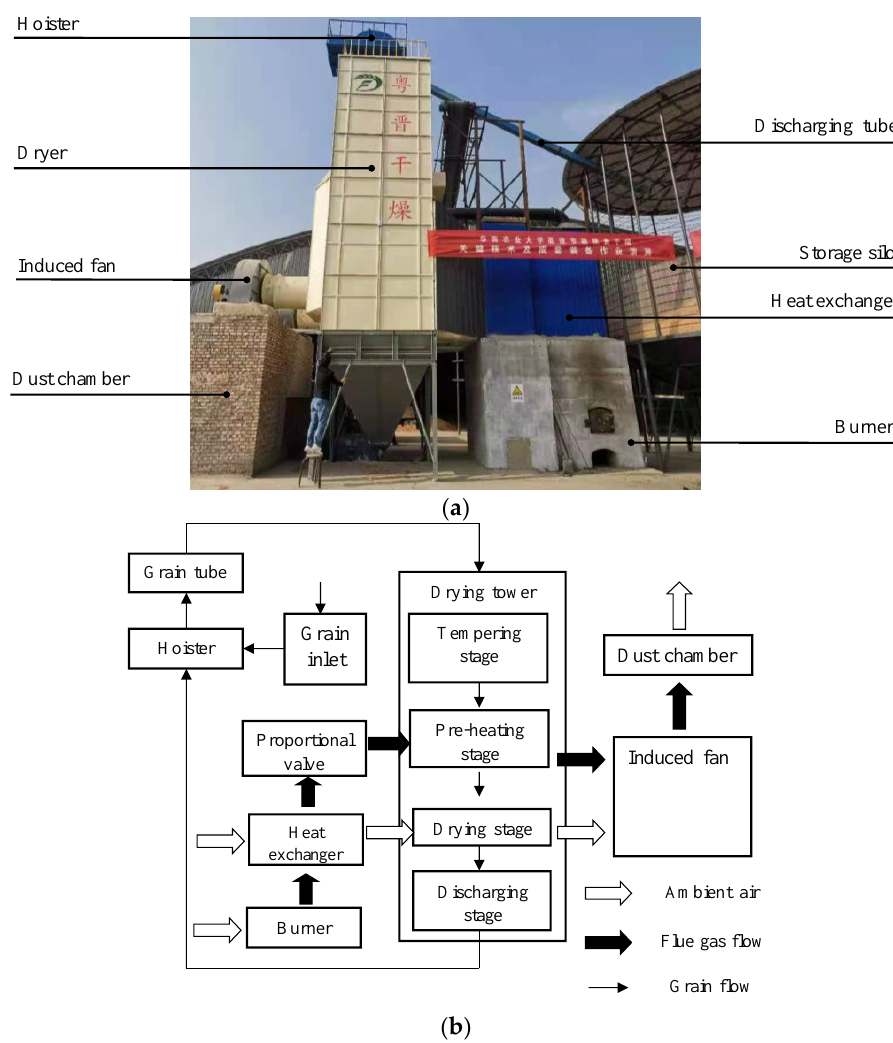
Figure 2. Circulation dryer ( a ) and its structure schematic ( b ).